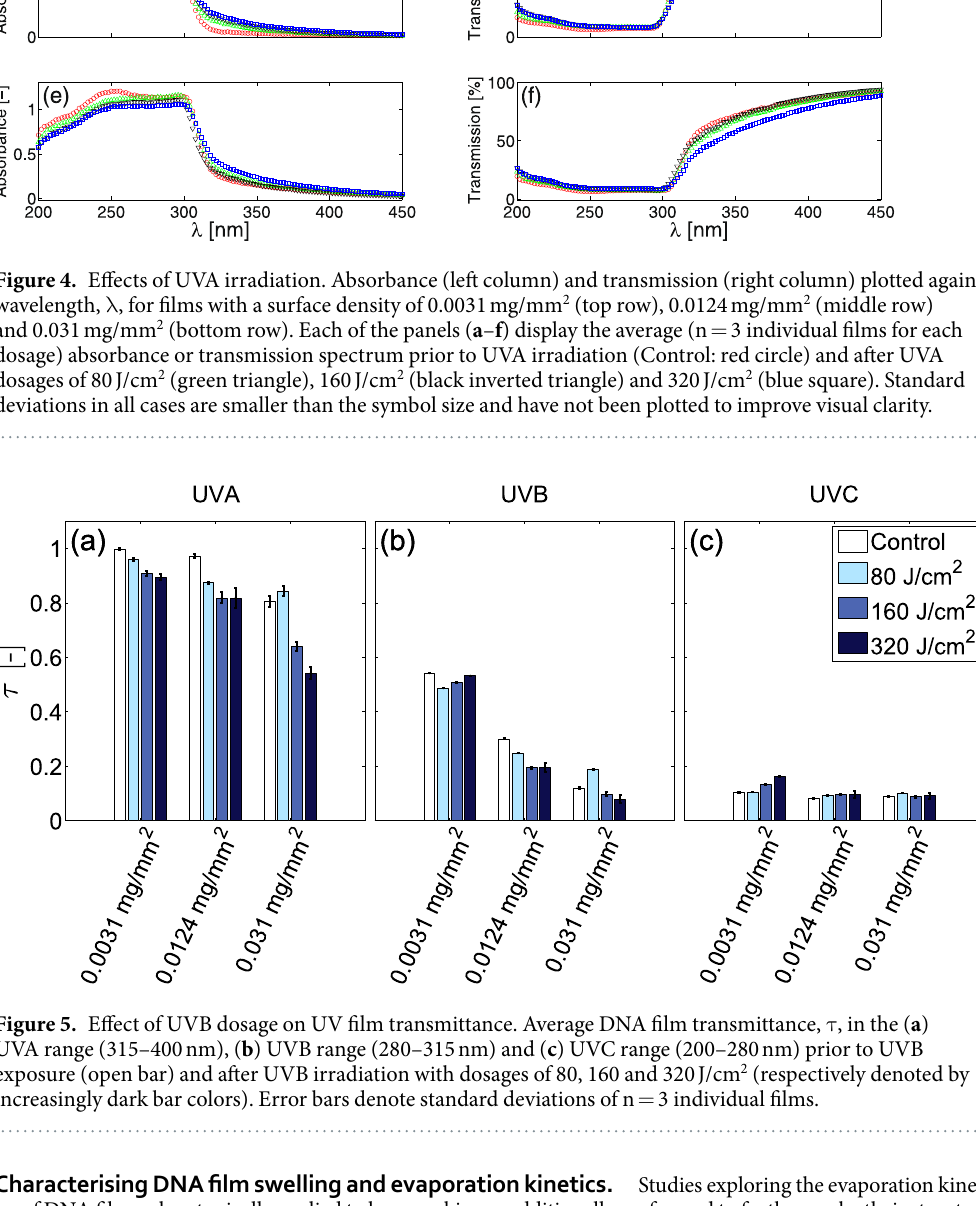
Characterising DNA film swelling and evaporation kinetics. Studies exploring the evaporation kinet- ics of DNA films when topically applied to human skin are additionally performed to further probe their structure and hygroscopic properties. Isolated samples of identically sized human stratum corneum (SC, surface area A = 1440 mm 2 ), the outermost layer of skin that governs trans epidermal water loss 45 are adhered to an elastomer coated aluminium substrate. Samples are then uniformly coated with 500 μ l of an aqueous DNA solution, then desiccated for 24 hr at 10% R.H to establish the total mass of SC sample, DNA film and substrate, M 0 . Once fully rehydrated, changes in the sample mass, M ( t ), are recorded over a 3.5 hr period within a controlled 24% relative humidity (R.H.) environment. This period is sufficiently long to observe drying behavior 46, 47 . Figure 7(a) displays changes in the area scaled average water mass of the SC and DNA films over time, = − M t M t . The fully hydrated area scaled water mass, M W (0), increases with film surface density. Subsequent drying over the first 60 min causes all coated and uncoated samples to rapidly dehydrate. Thereafter, the rate of drying decreases. After the first 20 min of drying, samples with 0.00173 mg/mm 2 coatings show no difference in M W relative to control